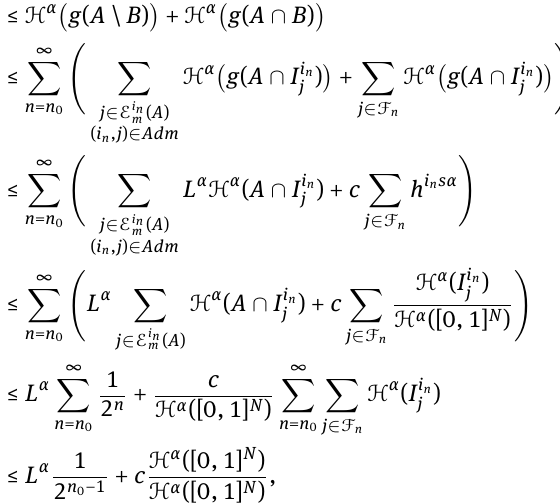
Thus, H α ( B ) = 0, and since g is Lipschitz, H α (cid:0) g ( B ) (cid:1) = 0. With these we can